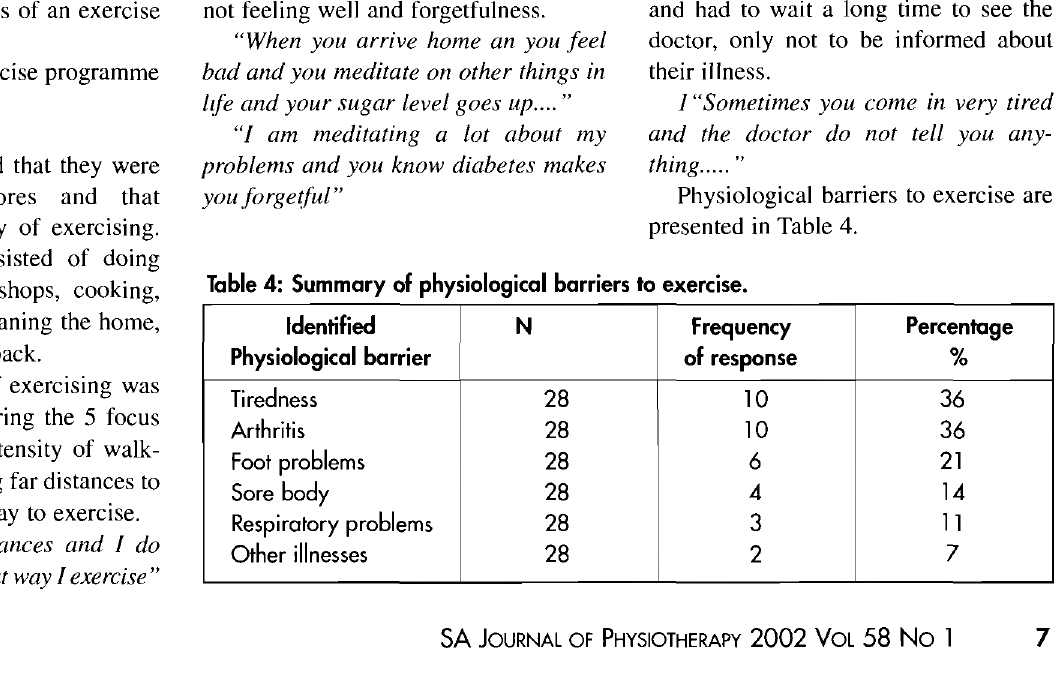
Table 4: Summary of physiological barriers to